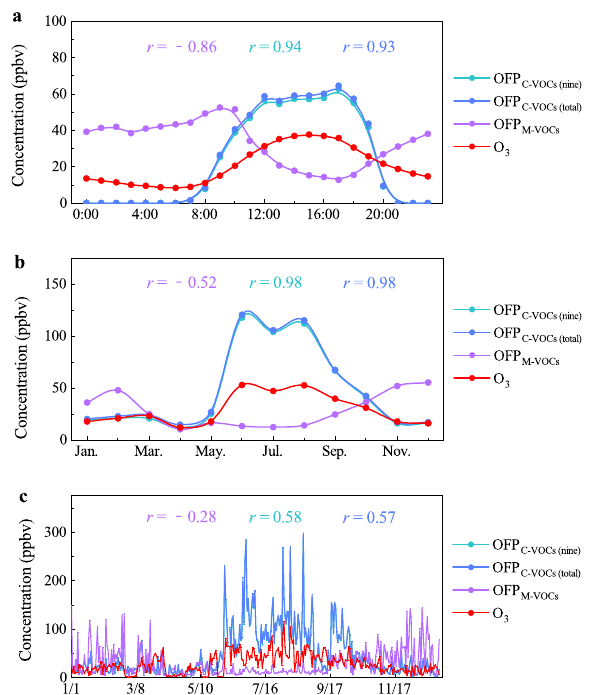
Fig. 3 The correlation of OFP C-VOCs (nine) , OFP C-VOCs (total) , OFP M-VOCs and O 3 . Time series of a diurnal variation, b monthly concentration, and c daily concentration of ozone formation potential (OFP) and O 3 . Note that the OFP C-VOCs (nine) and OFP C-VOCs (total) (OFP calculated based on the top nine or all C-VOCs) are higher than the observed O 3 especially in the summer. This may be because OFP C-VOCs calculates maximum ozone formation potential, though O 3 consumption during the summer is substantial. Or due to the uncertainty of maximum incremental reactivity (MIR) when applied to the airshed conditions in 2018 in Tianjin, China. And the in fl uence of physical processes (boundary layer height, etc.). Here, we mainly focus on the change trend of OFP and O 3 . The correlation between OFP C-VOCs and O 3 is obviously higher than that between OFP M-VOCs and O 3 , which further illustrates the important role of C-VOCs in O 3 formation.